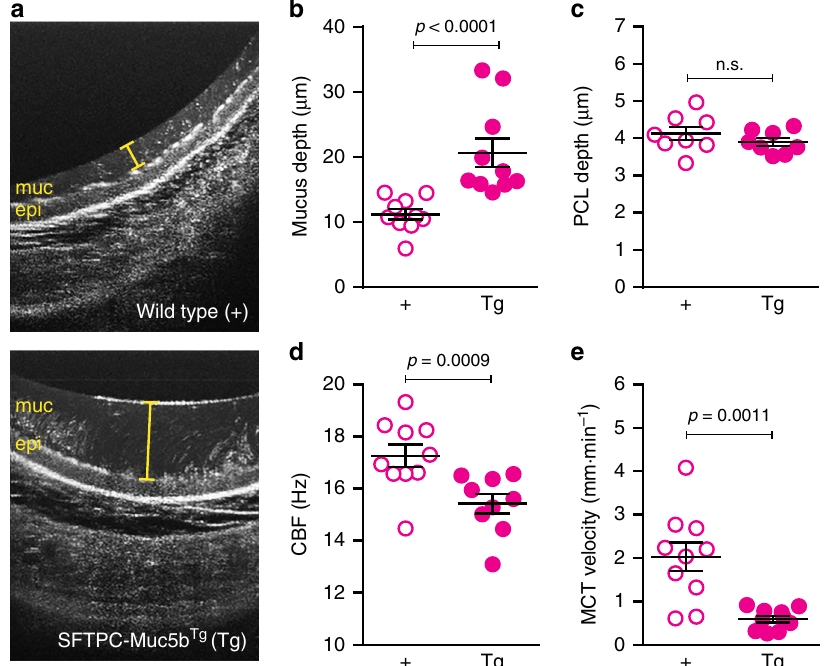
Fig. 2 Muc5b overexpression in SFTPC-Muc5bTg mice is associated with impaired mucociliary transport. a Representative μ OCT images of excised SFTPC- Muc5bTg mice trachea in comparison to trachea of wild type ( + ) littermate controls. b – e Quantitative metrics from image analysis reveal increased mucus layer depth b without signi fi cant alteration of periciliary layer (PCL) depth c in Tg mice compared to + controls. Functional analysis demonstrated reduced ciliary beat frequency d and diminished mucociliary transport rates e in Muc5b-overexpressing mice. Data in b – e are means ± sem and were analyzed